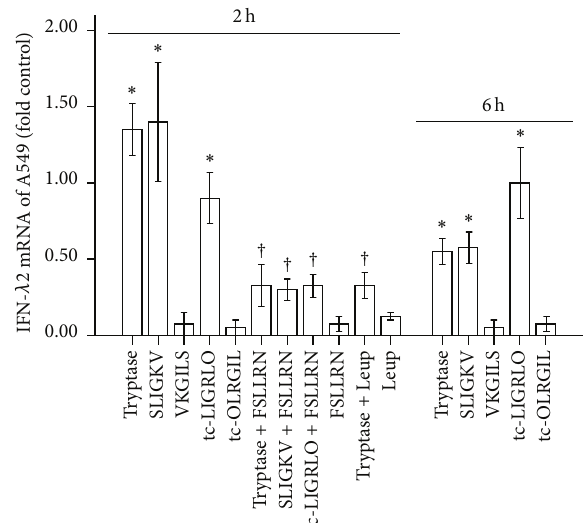
Figure 5: Induction of the expression of IFN- 𝜆 2 mRNA in A549 cells by tryptase and agonist peptides of PAR-2. Cells were treated with tryptase (2.0 𝜇 g/mL) with or without leupeptin (Leup, 3.0 𝜇 g/ mL), SLIGKV-NH 2 (SLIGKV, 100 𝜇 M) with or without FSLLRN- NH 2 , reverse peptide VKGILS-NH 2 (VKGILS, 100 𝜇 M), tc-LIGR- LO-NH 2 (tc-LIGRLO, 100 𝜇 M) with or without FSLLRN-NH 2 (FSLLRN, 400 𝜇 M), and reverse peptide tc-OLRGIL-NH 2 (tc- OLRGIL, 100 𝜇 M). Total cellular RNA was isolated and reversely transcribed to cDNA, and the cDNA was used for quantitative real- time PCR analysis. The data were normalized to the housekeeping gene ( 𝛽 -actin gene) and were expressed as mean ± SE fold of control for four separate experiments performed in duplicate. ∗ 𝑃 < 0.05 compared with the baseline control. † 𝑃 < 0.05 compared with the response to the corresponding stimulus